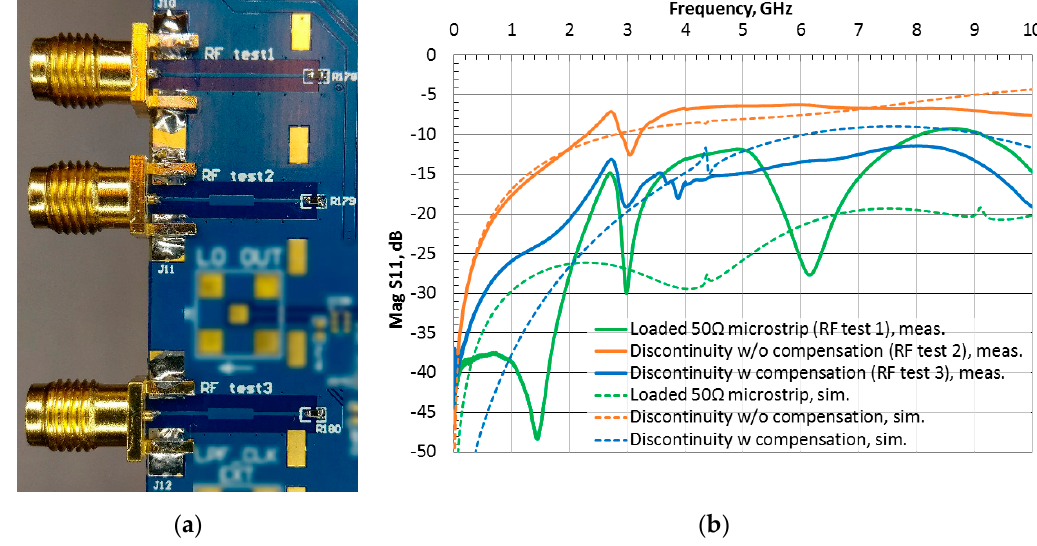
Figure 4. Manufactured 6-layer PCB with DUT structures ( a ), simulation and measurement results ( b ). The S -parameter simulation (dashed) and measurement (solid) results are presented in Figure